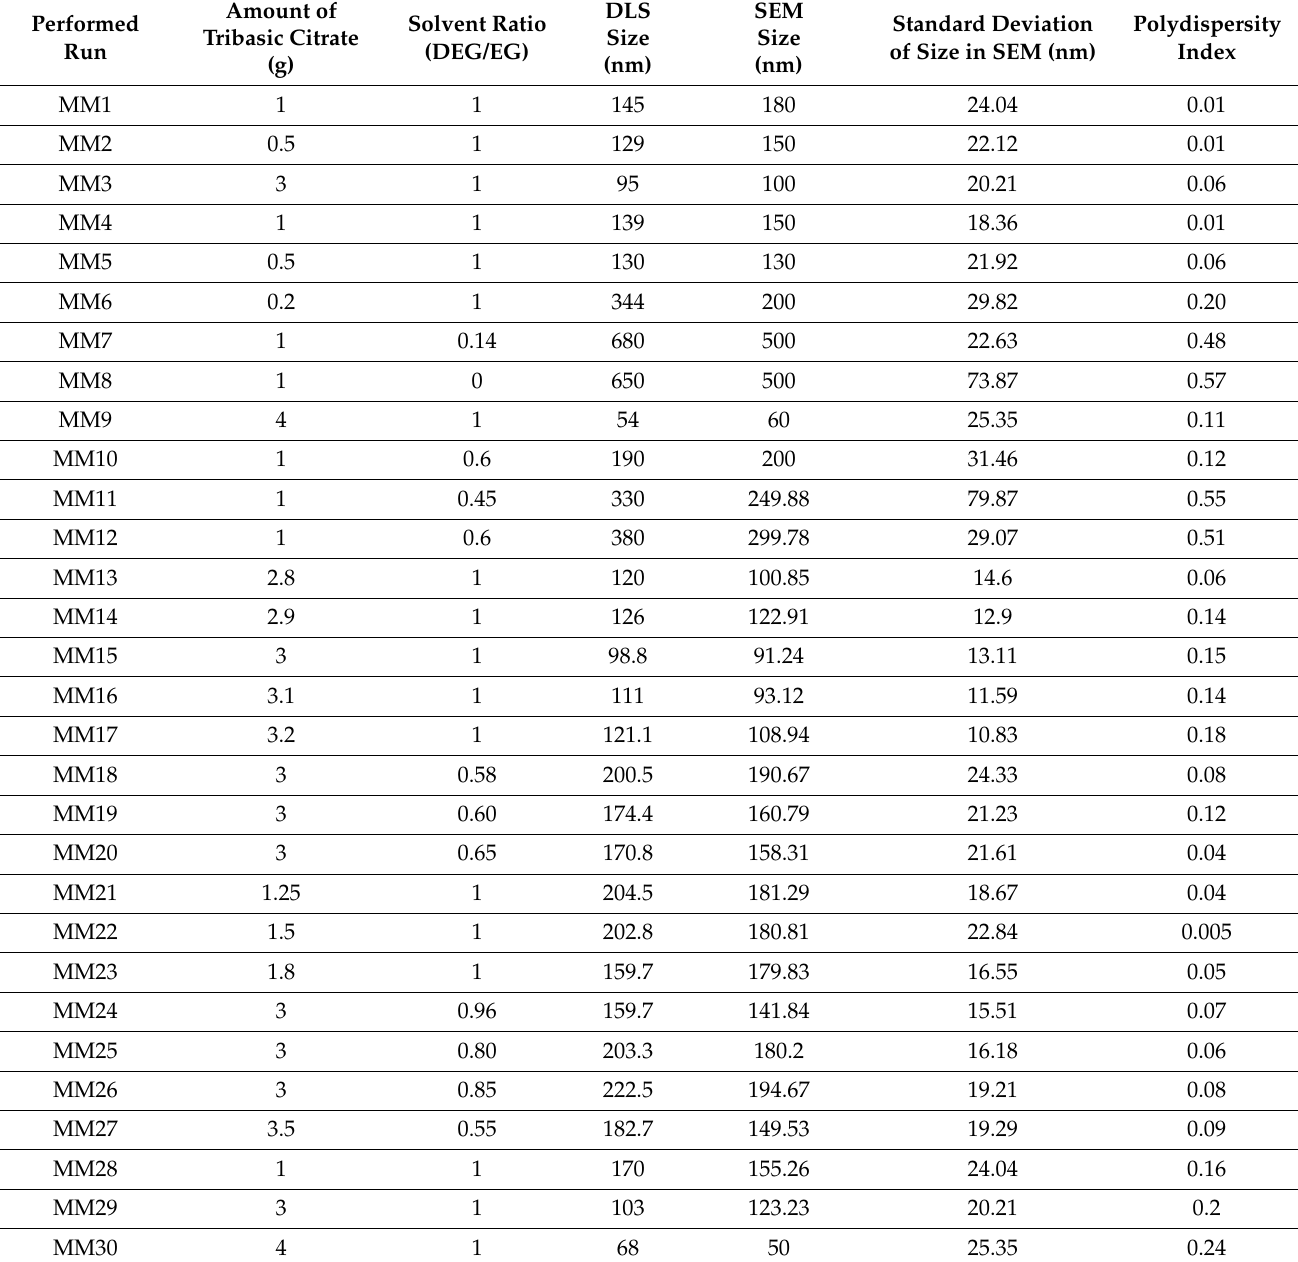
reaction was carried out for 10 h at 200 ◦ C. The obtained black precipitate, consisting of magnetite nanocrystal clusters with an average size of 150 nm, was washed via magnetic decantation. A first washing step was performed with distilled water, while a second washing step was performed with distilled water, the pH of which was increased to 10 (by means of NaOH) to promote deprotonation of the carboxyl groups on the surface of the clusters. In this manner, their electrostatic colloidal stability was enhanced and their aggregation was usually avoided. A small amount of tribasic citrate was added to the washing solvent to compensate for detaching citrate on the surface of the particles during washing. The washed nanocrystal clusters were eventually dispersed in 40 mL aqueous solution at pH 10. Table 1. Table showing the complete set of runs with the corresponding responses for the size (dynamic light scattering (DLS) and SEM) and the corresponding polydispersity index (PDI) for DLS and size deviation for SEM measurements.